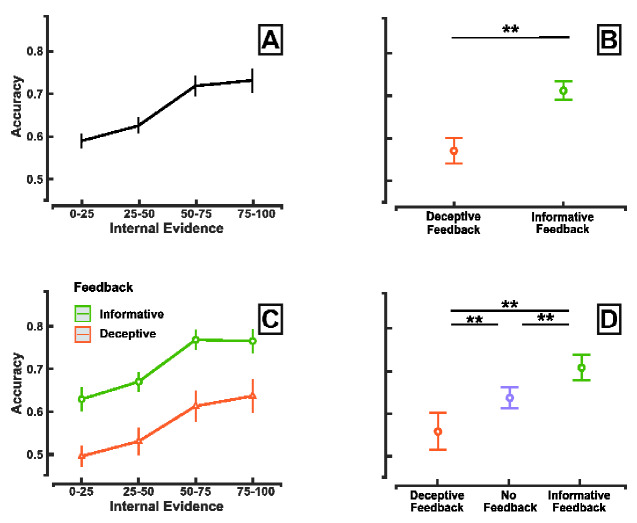
Respective influences of internal decision evidence and external cues on introspective reports. (A–C) Impact of internal evidence (IE) on the accuracy of introspective reports. For each participant, we computed the distribution of IE across trials in terms of percentile. Vertical bars represent bootstrapped confidence intervals across participants (1000 iterations). (B–D) Impact of the feedback cue on the accuracy of introspective reports. Error bars represent the standard error to the mean (SEM). N = 30 in A, B and C. N = 16 in D. Significance marker: ** p<0.01.